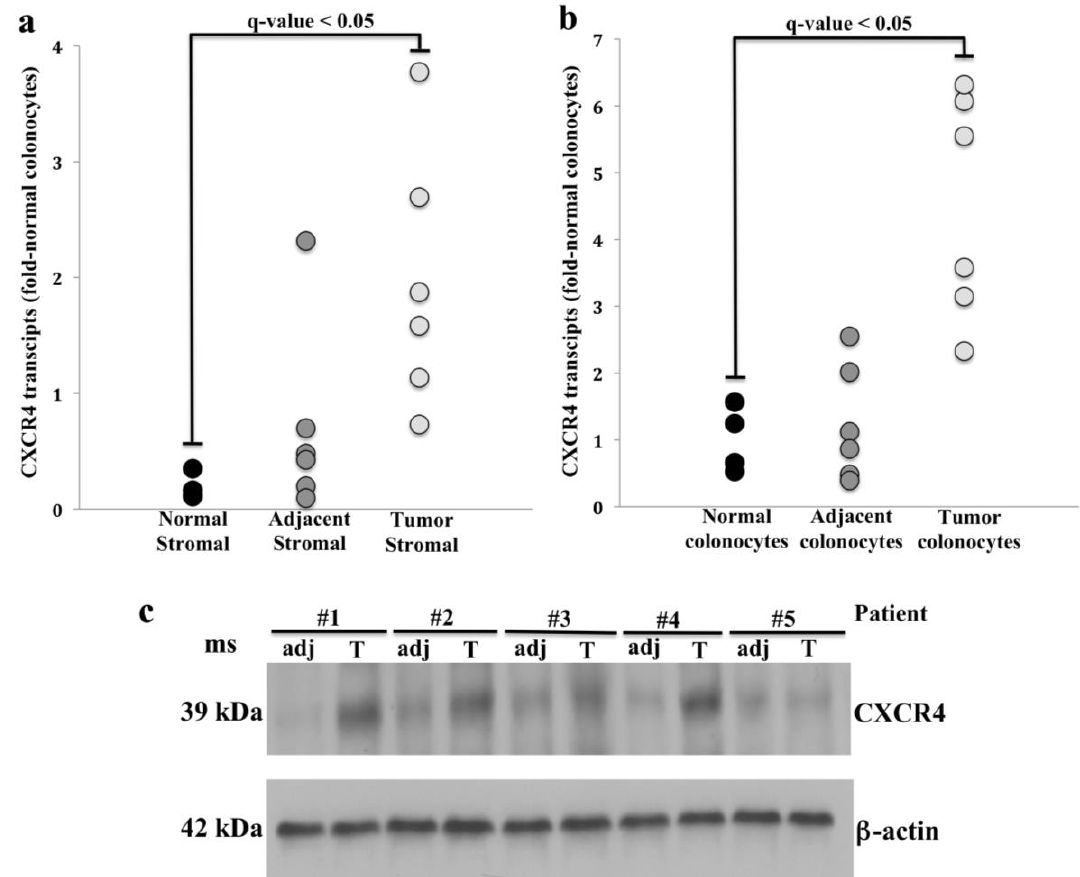
Figure 1. C-X-C motif chemokine receptor 4 (CXCR4) transcript and protein expression in tumor and adjacent normal tissue. RT-PCR analysis of CXCR4 transcript abundance in normal and tumor tissue: ( a ) stromal cells and ( b ) colonocytes after multiple testing correction (Tukey post hoc test, Supplementary Table S1). Note the increase of CXCR4 transcripts in both tumor stromal cells and colonocytes compared to adjacent matched tissue controls ( q -value < 0.05). ( c ) CXCR4 protein expression in tumor colonocytes (T) and normal colonocytes adjacent to tumor (adj). Note the increased CXCR4 protein expression in tumor colonocytes compared to adjacent colonocytes from normal appearing mucosa ( n = 5; p -value < 0.05, paired Student’s t -test, Supplementary Table